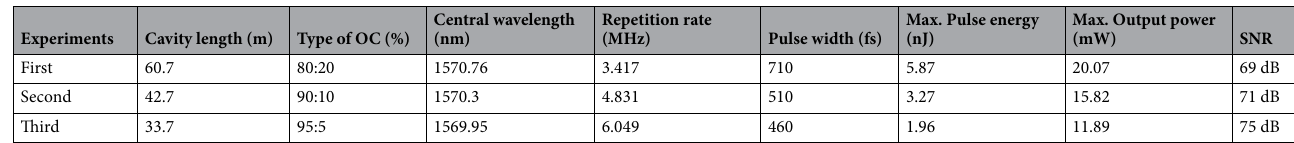
Table 1. Summary of performance of three mode-locked EDFL